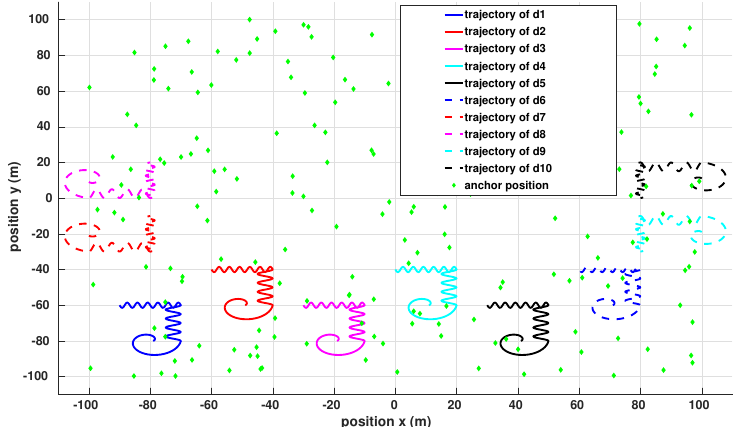
Figure 8. Multi-drone and anchor localization scenario. Fixed anchors with unknown positions are marked with green dots. The ten drones and their local trajectories are represented using solid and dashed curves of different colors.